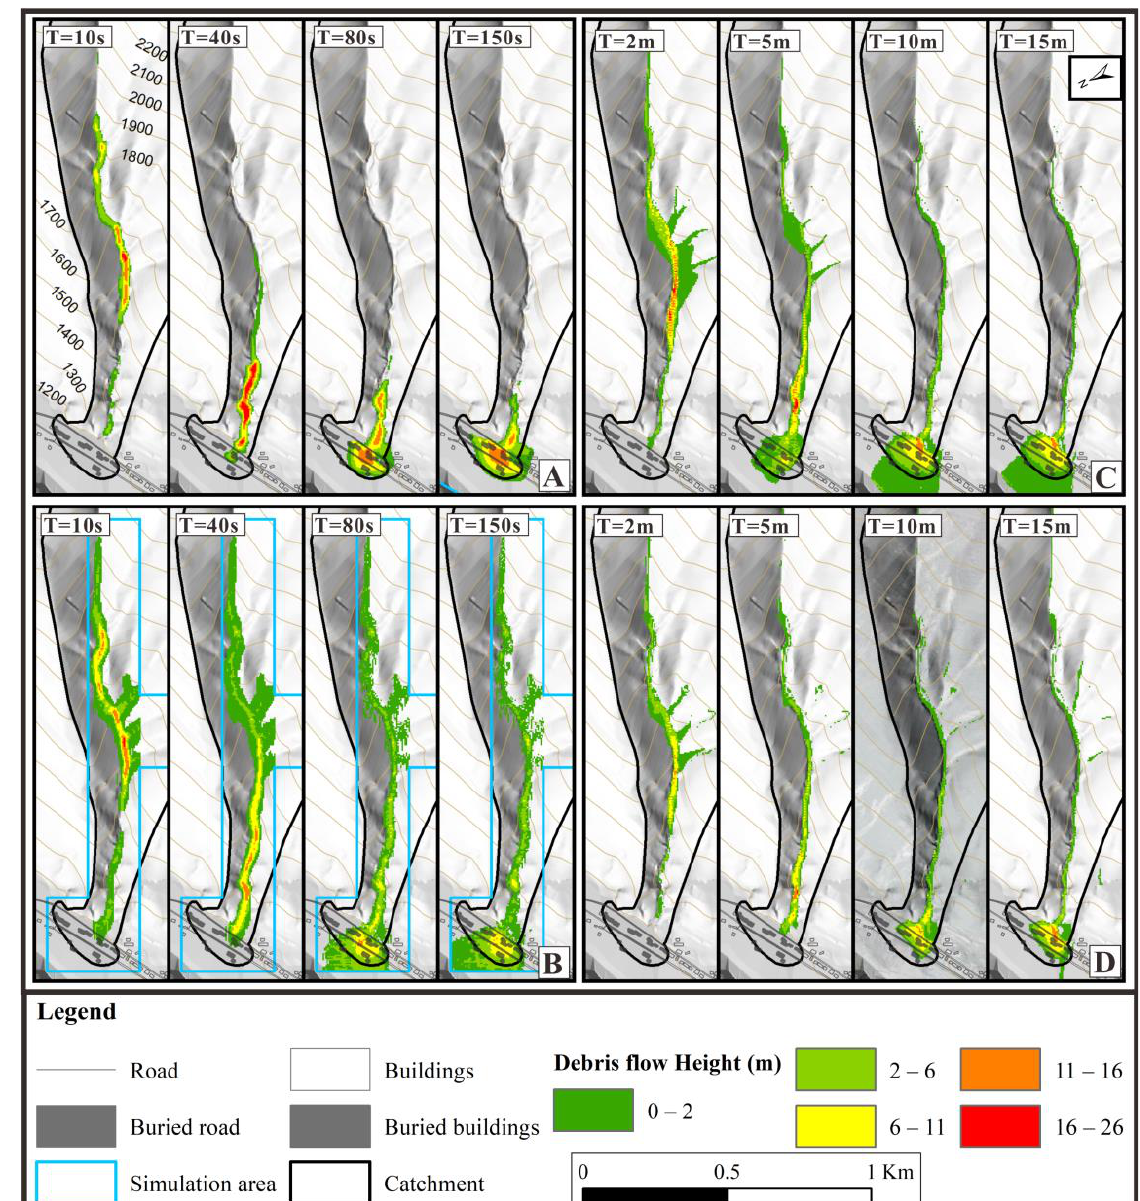
Figure 10. Snapshots of the debris flow height of Wayao debris flow in 2013 simulated by Massflow ( A ), Flow-3D ( B ), OpenLISEM_A ( C ), and OpenLISEM_B ( D ). Abbreviations: s means seconds, and m means minutes.